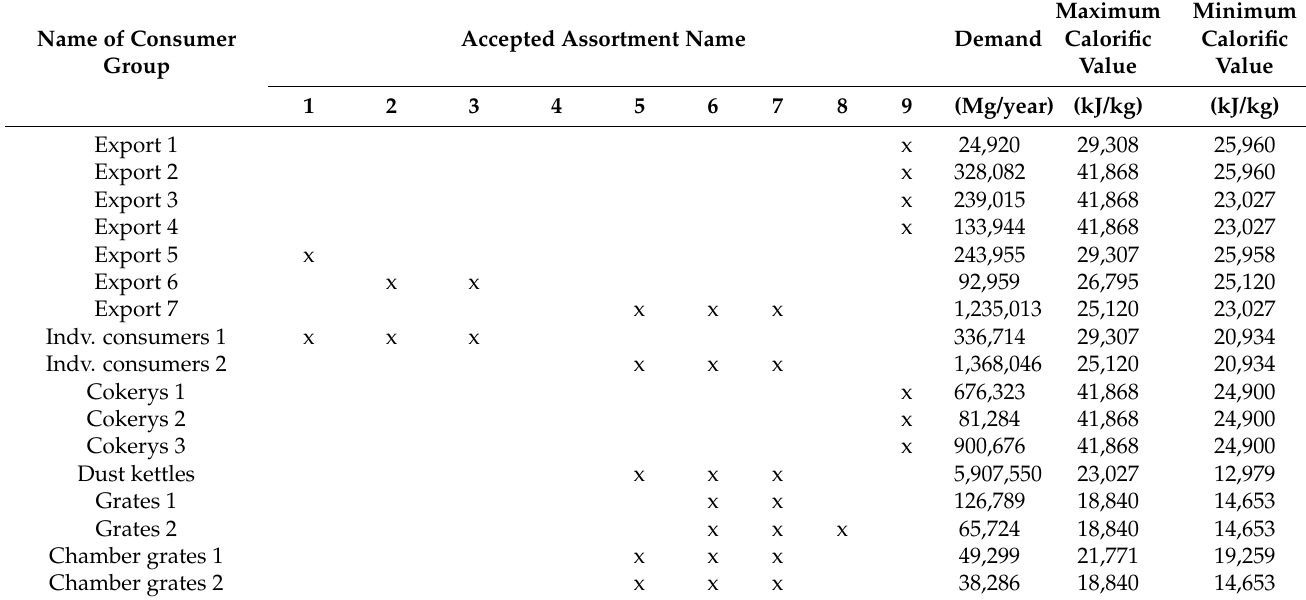
Table 4. The characteristics of the company’s aggregated consumer groups.